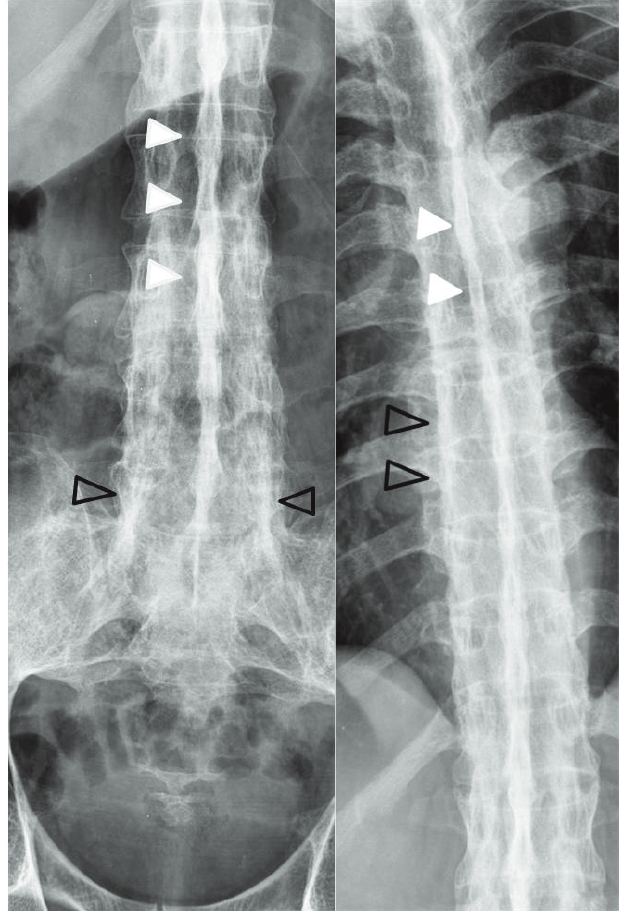
Fig. 3. Antero-posterior view of the thoracic and lumbar spine. Note the calcification of the interspinous ligaments secondary to enthesitis, with the classic dagger sign (white arrowheads) stretching into the pelvis. The trolley track sign can also be seen in the lower lumbar spine and thoracic spine (open arrowheads), lateral to the calcified interspinous ligaments, representing the calcified apophyseal joint